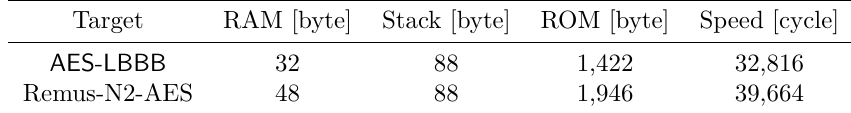
Table 3: Software performance evaluation of AES - LBBB and Remus-N2-AES. Speed is measured with a 16-byte associated data and a 256-byte